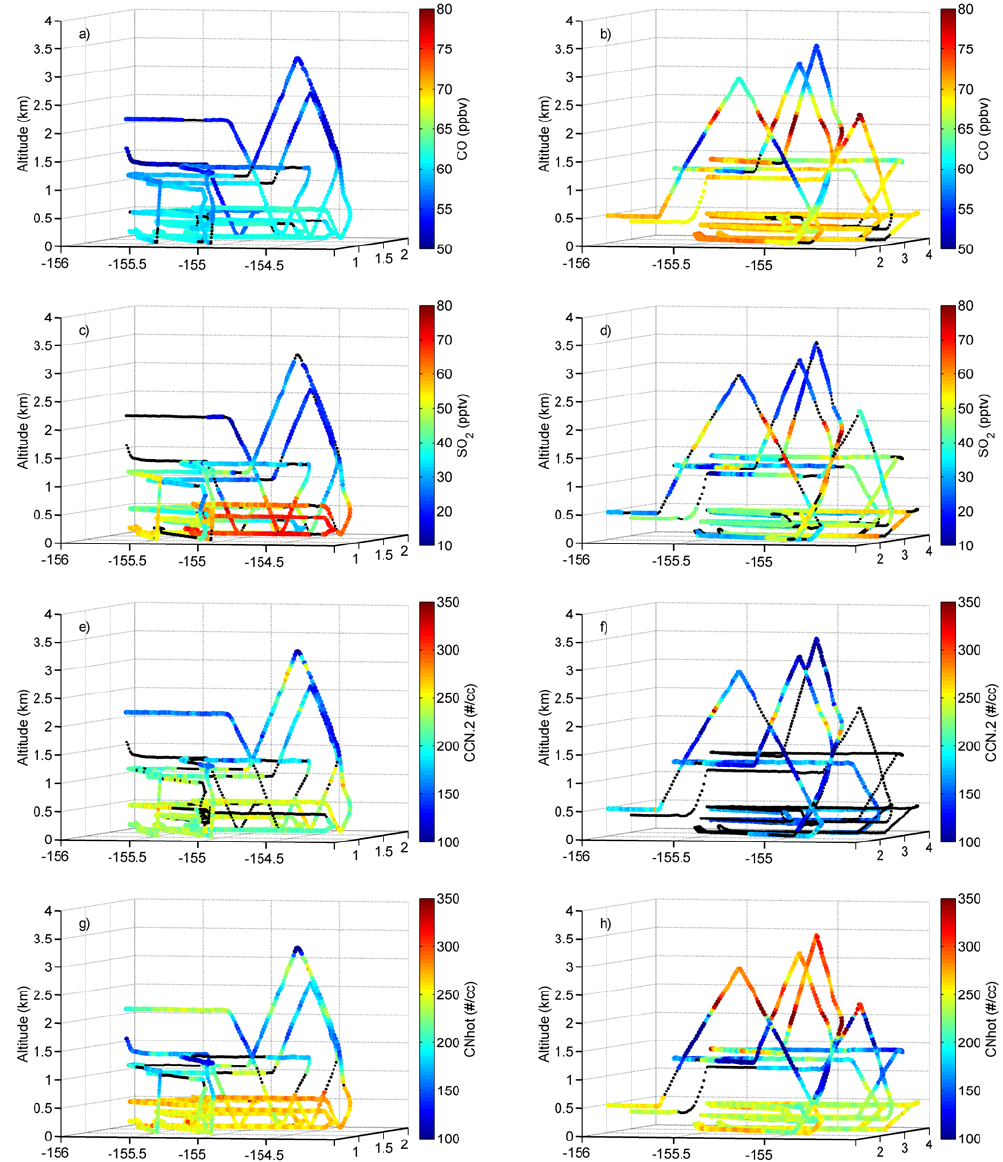
Fig. 2. Examples of a low CO (RF03, 13 August, left panels) and higher CO (RF08, 25 August, right panels) flights with selected data color coded along path as indicated. Black line indicates no data